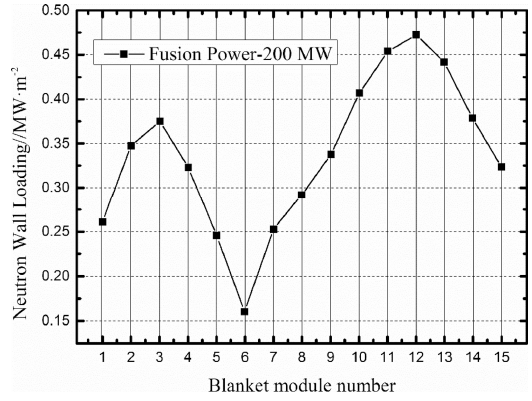
Figure 5. Neutron Wall Loading (NWL) on each HCSB blanket.